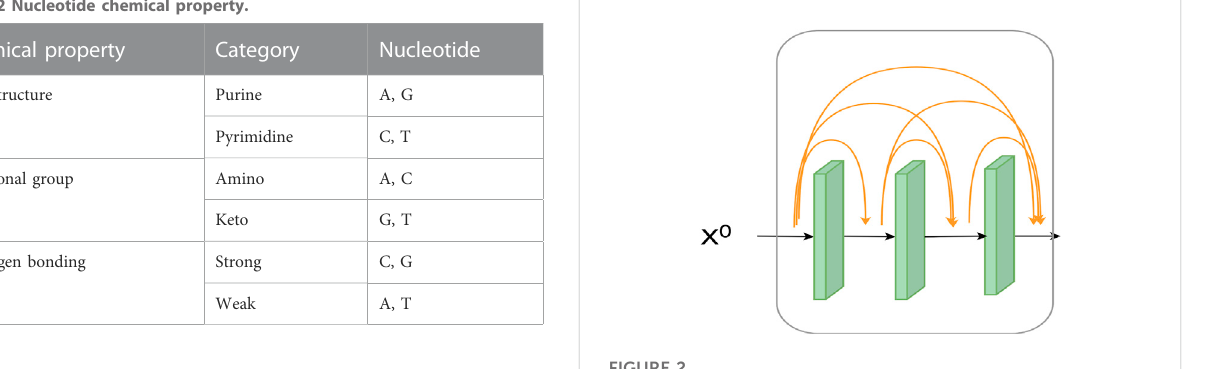
FIGURE 2 Structure of a dense